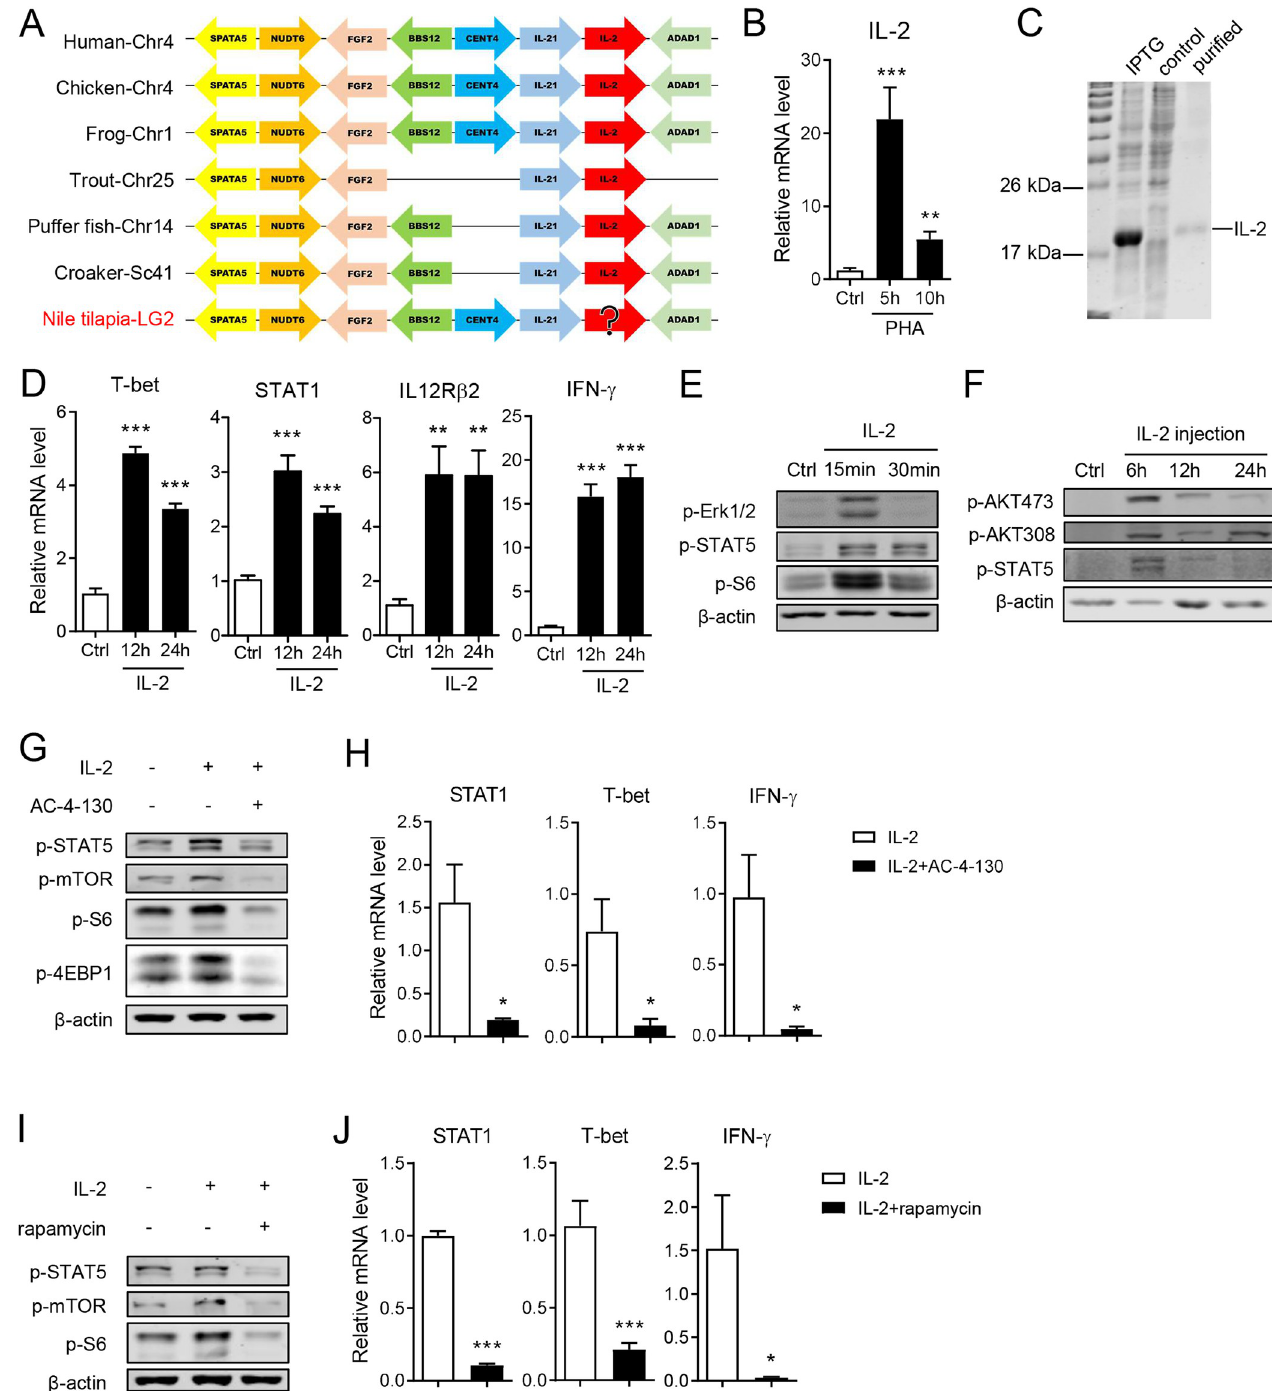
Fig 6. IL-2 promotes Th1 cell differentiation of tilapia by activating STAT5 and mTORC1 signaling. ( A ) Synteny analysis of tilapia IL-2 and other homology genes by comparative genomics. ( B ) Spleen leukocytes were stimulated with PHA, and mRNA levels of IL-2 were examined by qPCR, n = 6. ( C ) SDS-PAGE assay showed the recombination of tilapia IL-2 protein in E . coli . ( D, E ) Spleen leukocytes were treated with recombinant IL-2, and expression of indicated molecules were examined by qPCR ( D , n = 6) or western blot ( E ) at indicated time points. ( F ) Tilapia individuals were i . p . injected with recombinant IL-2, the expression of indicated molecules were examined by western blot. ( G, H ) Spleen leukocytes were stimulated with recombinant IL-2 in the presence of STAT5 inhibitor AC-4-130 for 12 h. The expression levels of indicated molecules were examined by western blot ( G ) or qPCR ( H , n = 4). ( I, J ) Tilapia was injected with mTORC1 inhibitor rapamycin for 2 days before spleen leukocytes were stimulated with recombinant IL-2 for 12 h. The expression levels of